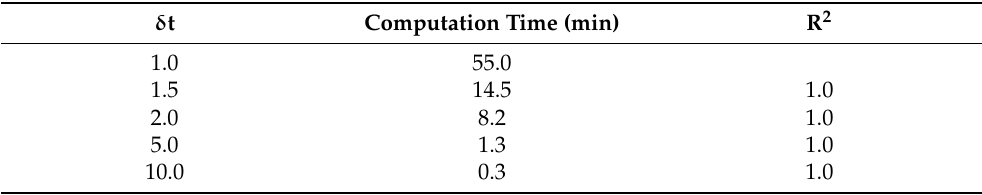
Table 2. Computation time for different time steps ( δ Figure 7. Flow profiles every 13 min of a border irrigation with a shallow water table.